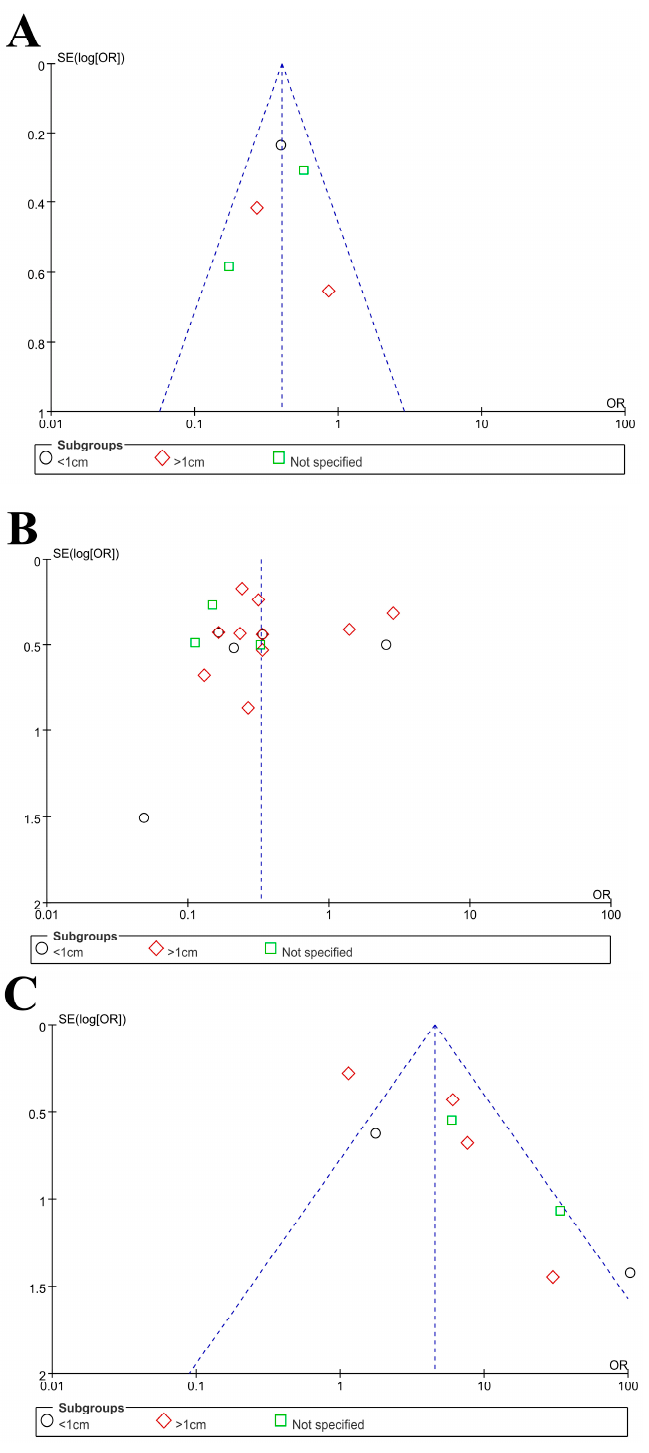
Figure 2. Funnel plot: ( A ) Stone-free rate (SFR) in randomized controlled trials (RCTs), ( B ) SFR in non-RCTs, ( C ) Retreatment.